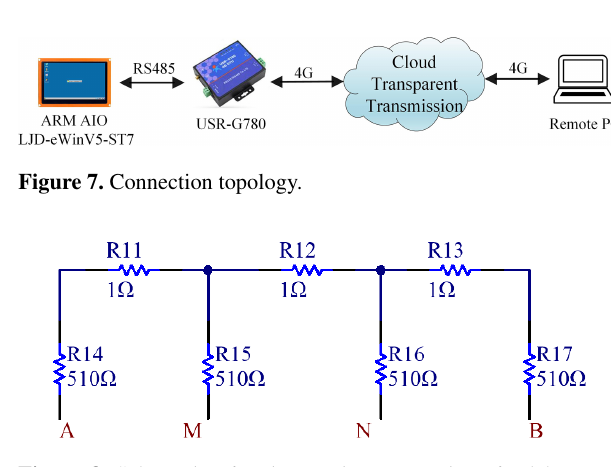
Figure 8. Schematic of resistor string connections for laboratory